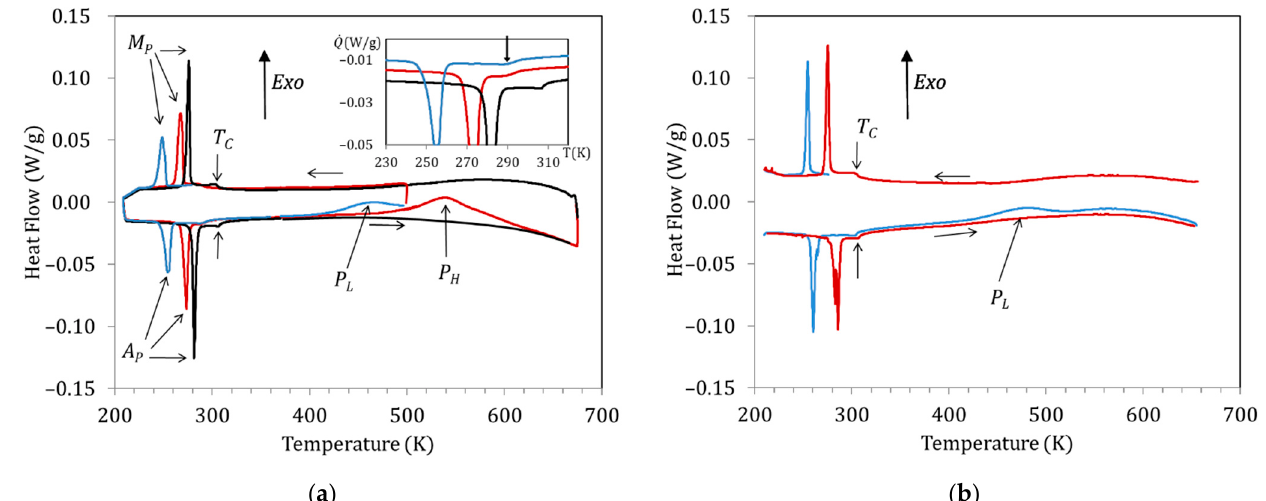
Figure 2. DSC curves obtained for a Cu5 sample ( a ) water quenched from 1020 K: just-quenched (blue curve), after overcoming P L (red curve), and after passing P H (black curve). ( b ) Just after quench from 770 K (blue curve) and ( b ) quenched from 770 K: just-quenched (blue curve) and after heating up to 670 K (red curve).